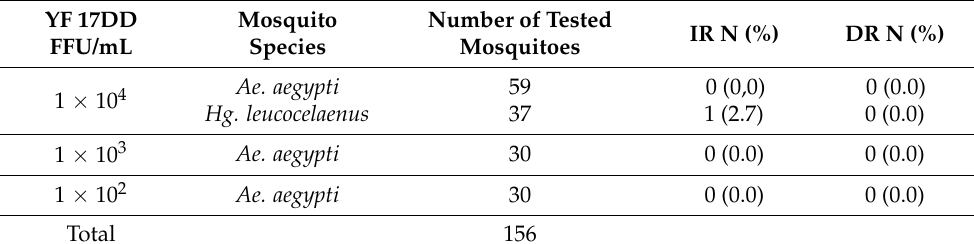
Table 2. Parameters that determine vector competence evaluated in females of Aedes aegypti and Hg. leucocelaenus experimentally challenged orally with three different dilutions of the YF 17DD attenuated vaccine, after 14 days of